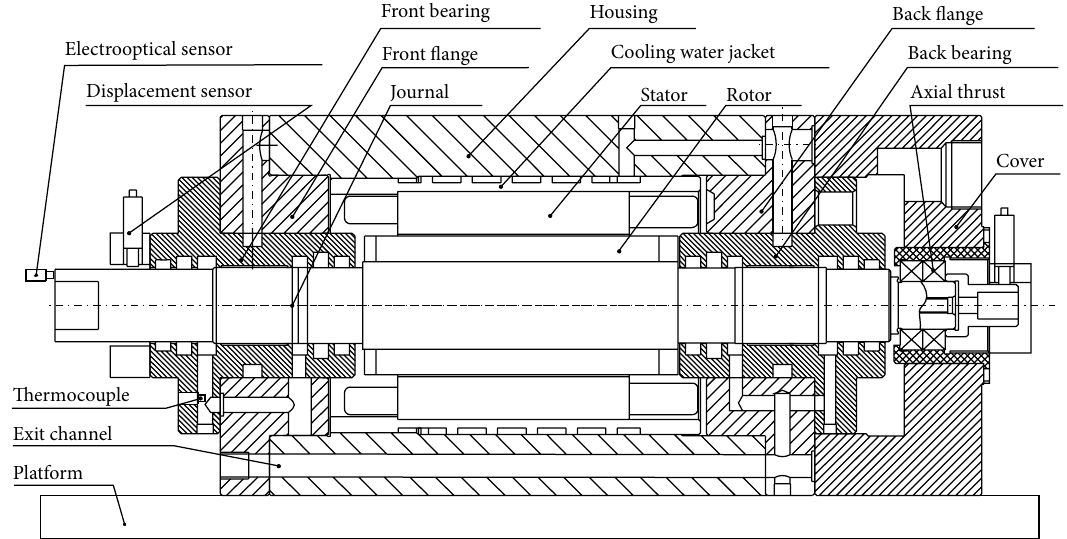
Figure 1: Schematic of high-speed spindle system test